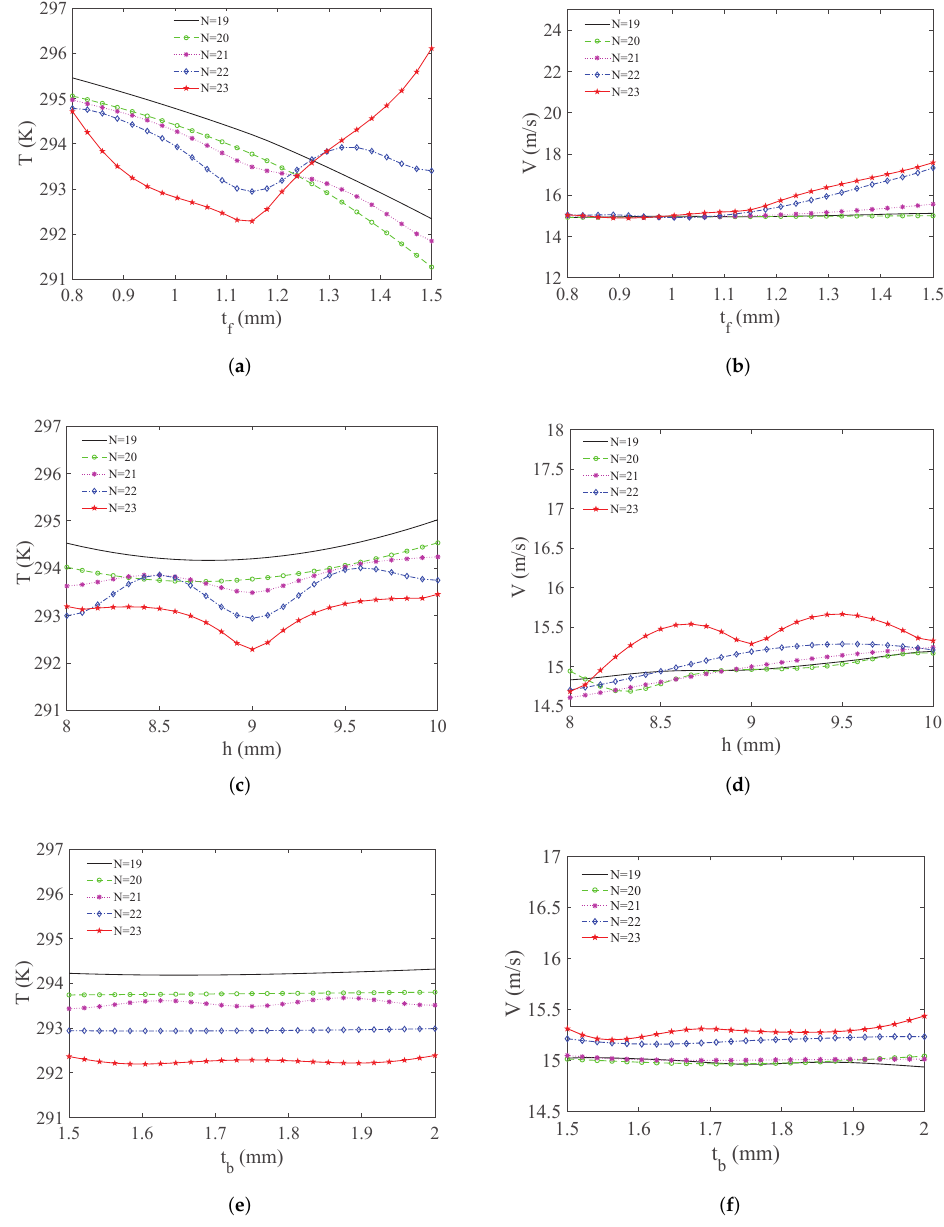
Figure 6. Variations of T and V for different N : ( a ) variation of T with t f ; ( b ) variation of V with t f ; ( c ) variation of T with h ; ( d ) variation of V with h ; ( e ) variation of T with t b ; ( f ) variation of V with t b